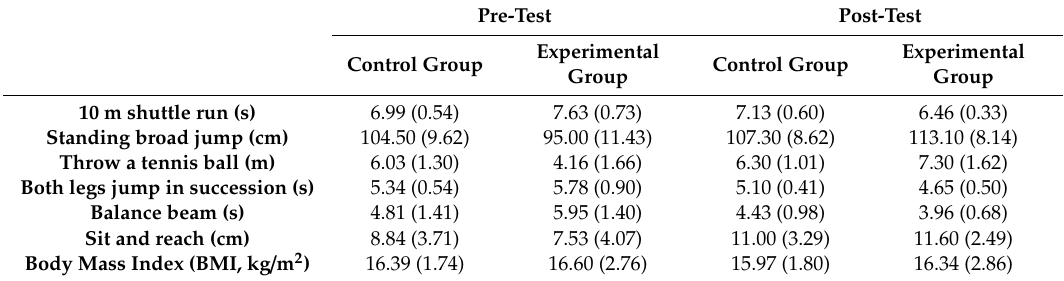
Table 1. Means and standard deviations for two groups on measures of physical fitness, M (SD).